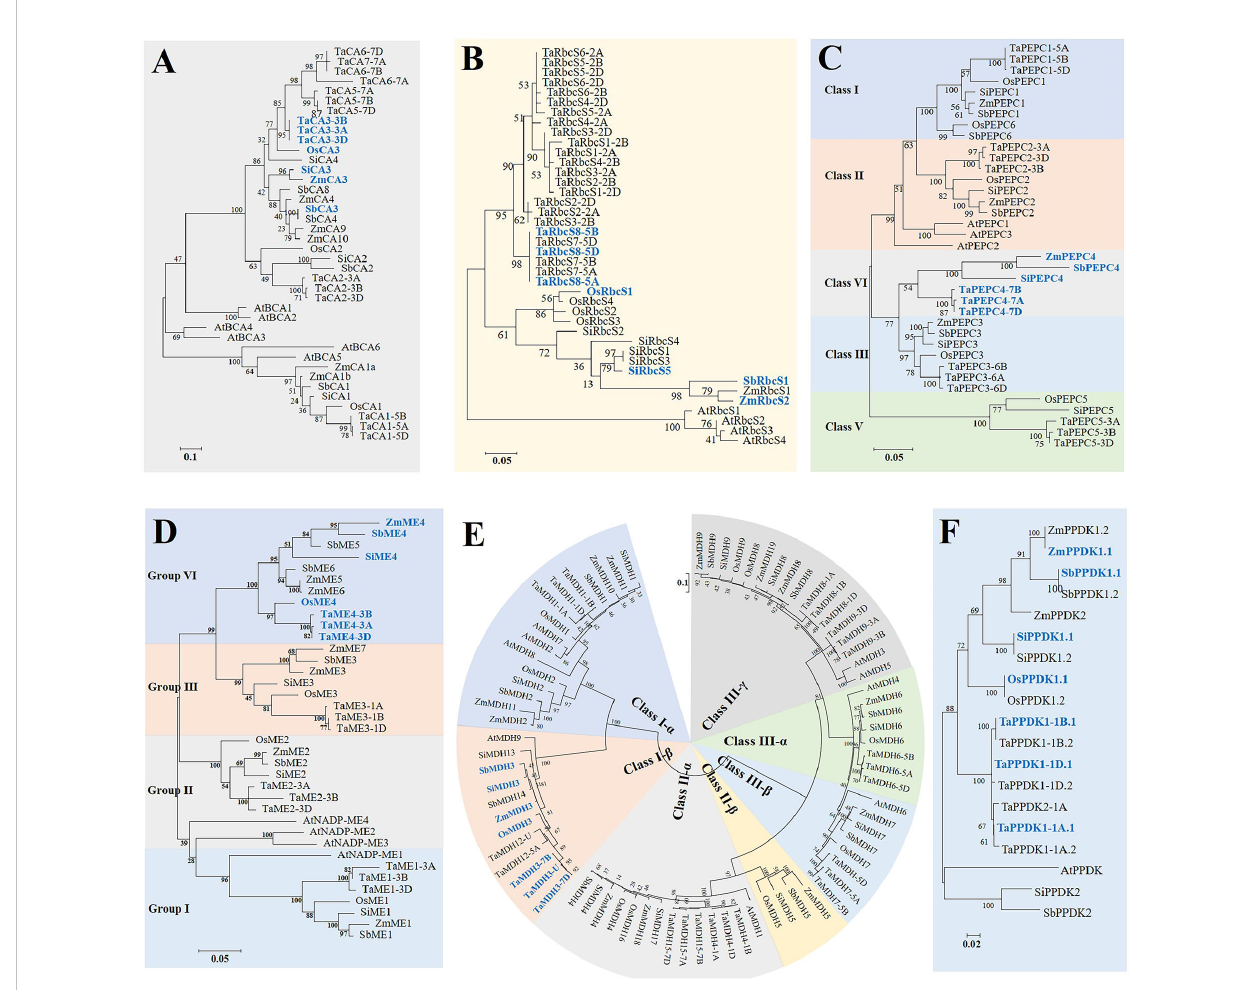
FIGURE 1 Phylogenetic relationships between six gene families involved in the C 4 photosynthetic pathway from common wheat (Ta), maize (Zm), foxtail millet (Si), rice (Os), sorghum (Sb), and Arabidopsis (At) based on their amino acid sequences. Multiple sequence alignment and phylogenetic tree construction were performed using MUSCLE and MEGA 6.0 (maximum likelihood method, JTT model), respectively. Scale bars indicate the number of amino acid substitutions per site. Genes presented in bold blue fonts represent C 4 -type copies in C 4 species. (A) b -CA; (B) RbcS; (C) PEPC; (D) NADP-ME; (E) MDH; (F)